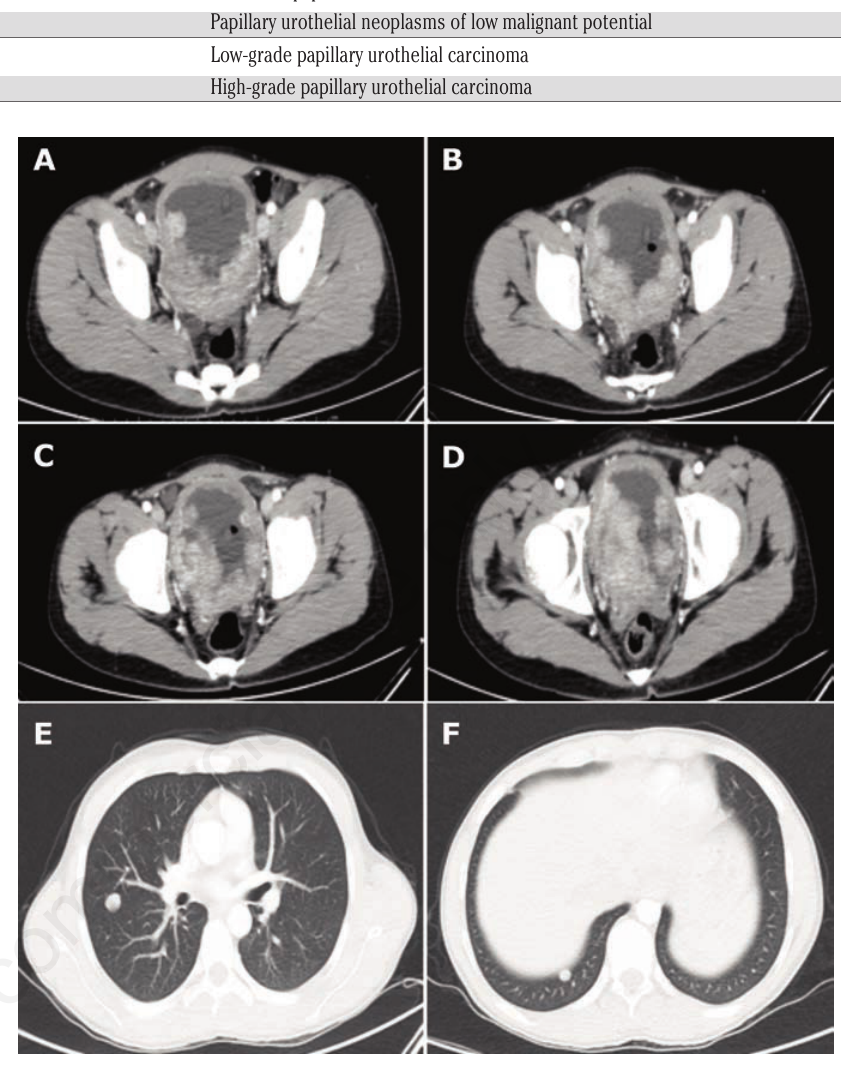
Figure 1. A-D) Preoperative contrast enhanced computerized tomography of the patient. Most of the lateral and posterior walls are occupied with the tumor. E,F) Computerized tomography of the thorax revealed multiple nodular metastatic